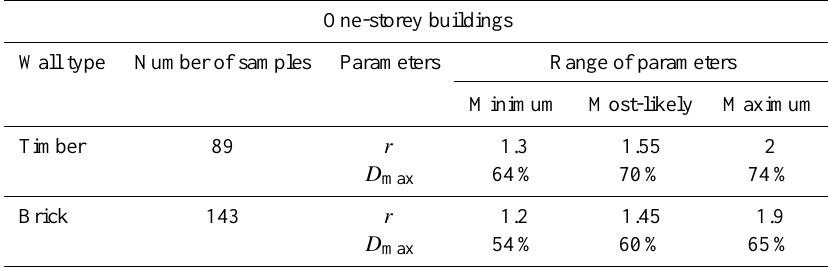
Table 2. Number of samples and range of r and D max values, calculated by the bootstrap and chi-square test for one-storey buildings.